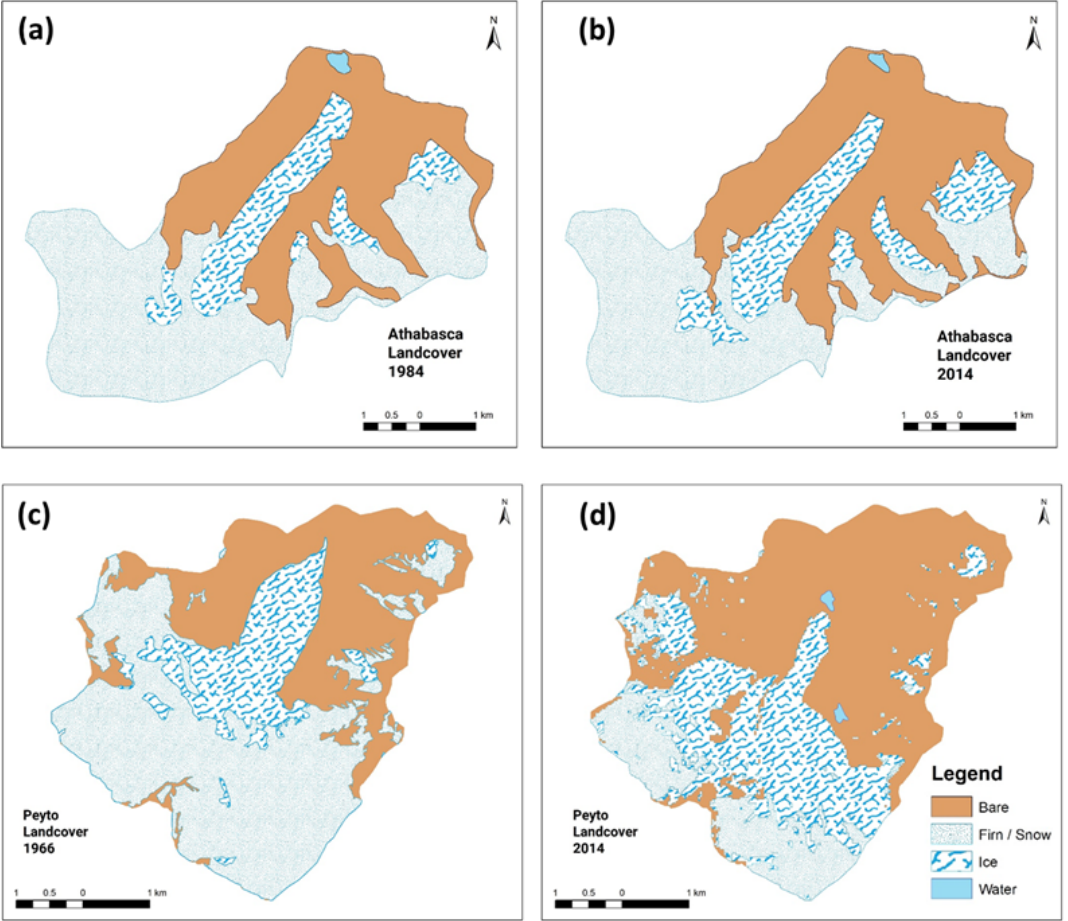
Figure 5. Change in land cover between the glaciers in the past and present. Panels (a) and (b) are AGRB in 1984 and 2014, respectively. Panels (c) and (d) are PGRB in 1966 and 2014, respectively.